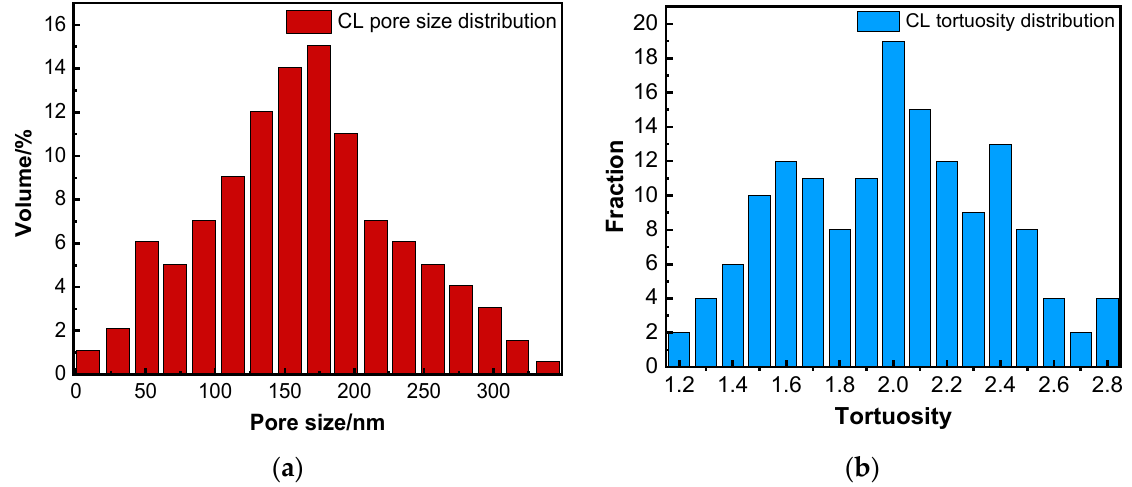
Figure 2. ( a ) Pore size distribution and ( b ) tortuosity distribution of CL.